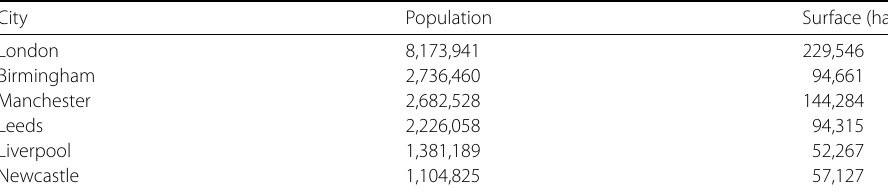
Table 1 Population and area of the six cities under study. Source: UK Census 2011 [46] City Population Surface (ha) London